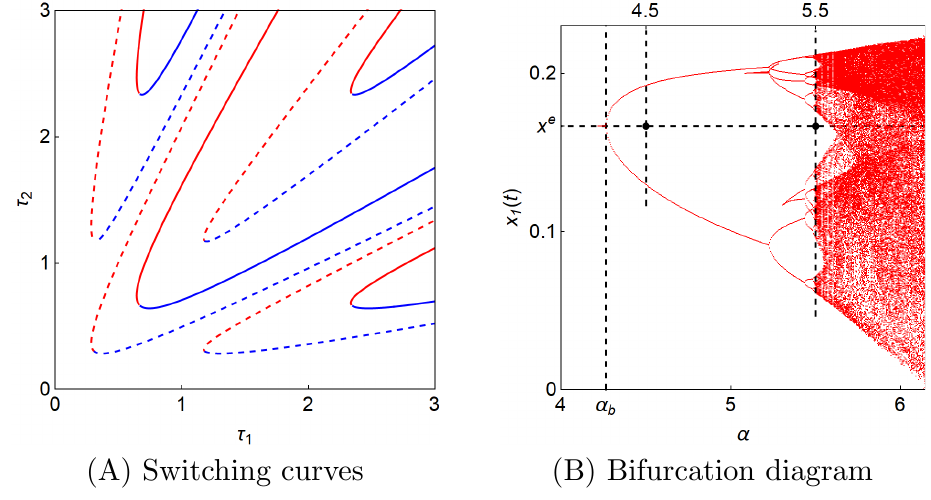
Figure 5. The α -destabilizing Figure 5. The (cid:11) -destabilizing e⁄ect